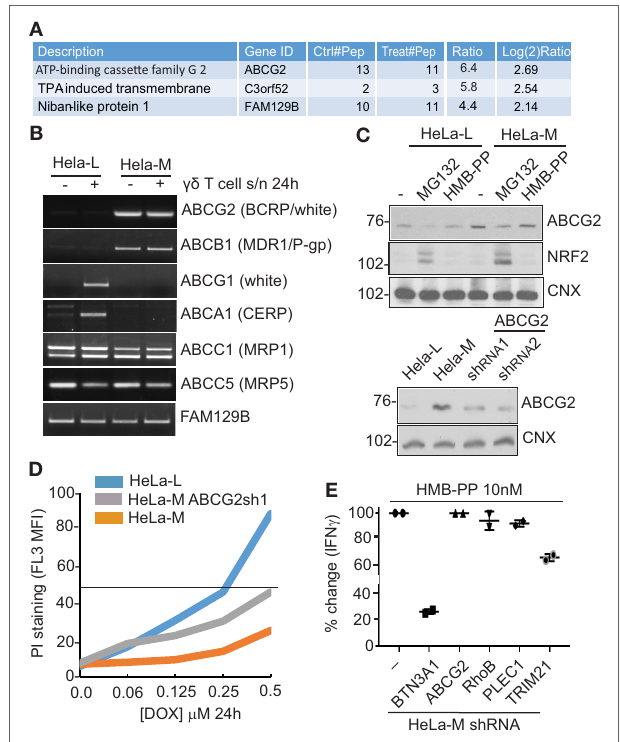
FigUre 4 | Plasma membrane profiling (PMP) by mass spectroscopy identifies ABCG2. (a) Table of top hits identified using PMP to compare HMB-PP treated and untreated HeLa-M cells. Several independent peptides of ATP-binding cassette (ABC) transporter ABCG2 were detected, with modest increase (log 2 2.69) by treatment. Other potential candidates by these criteria (C3orf52 and FAM129B) are listed and were less significant. (B) Dysregulation of a subset of ABC transporters, including ABCG2, in HeLa cells detected by RT-PCR. Template cDNA was prepared from total RNA from HeLa-L and HeLa-M cells left untreated or treated with γδ T cell supernatant for 24 h. RT-PCR products were analyzed by gel electrophoresis. (c) Variation in ABCG2 protein expression in HeLa cells by western blot. Top panel: HeLa-L and HeLa-M cells were left untreated or treated with MG132 (5 µM for 10 h) or HMB-PP (10 nM for 10 h). Cell lysates were prepared and analyzed using antibodies directed to ABCG2, NRF2, and calnexin (CNX), which acts as a loading control. Bottom panel: western blot analysis of shRNA ABCG2 cells confirms reduction in ABCG2 protein expression. (D) HeLa-M cells show ABCG2-dependent resistance to cytotoxic drug doxorubicin (DOX). Wild-type HeLa-M, HeLa-L, and shRNA ABCG2 HeLa-M cells were incubated (24 h) with DOX at the indicated concentrations. Cells were stained using propidium iodide (PI) (2.5 µg/ml for 5 min) as a marker of plasma membrane integrity. After washing, cells were analyzed by cytometry. Chart shows mean fluorescence intensity (MFI) of PI staining. (e) No effect on T cell activation using shRNA ABCG2 HeLa-M cells. The effect on the efficiency of V γ 9/V δ 2 T cell activation for a series of HeLa-M gene knockdown lines, including shRNA BTN3A1, ABCG2, RhoB, PLEC1, and TRIM21. Cells were pretreated with HMB-PP (10 nM for 6 h) before V γ 9/V δ 2 T cells from a single donor were applied. Coculture was allowed to proceed overnight when culture supernatants were analyzed by ELISA. Chart shows percent (%) change in detected IFN- γ relative to wild-type HeLa-M cells of duplicate determinations for each cell